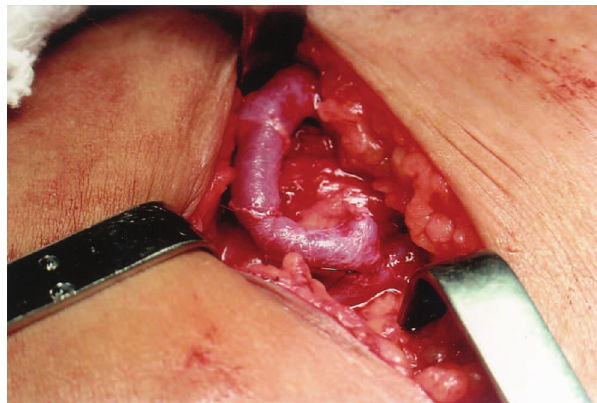
Figure 2 - Brachiocephalic arteriovenous fistula. Note the termino- lateral anastomosis of the vein to the